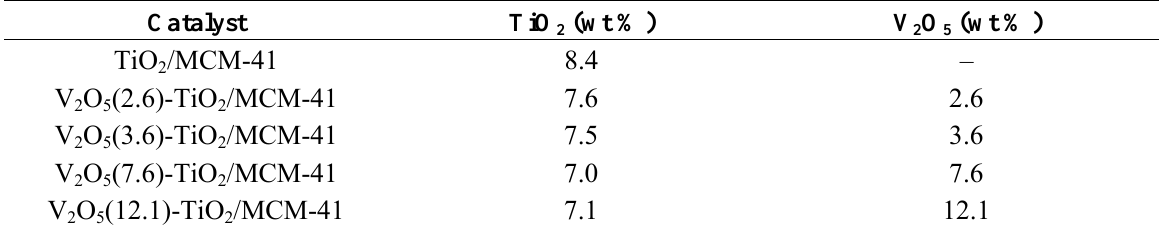
Table 1. Loading amount of metal oxides on MCM-41 determined by inductively coupled plasma